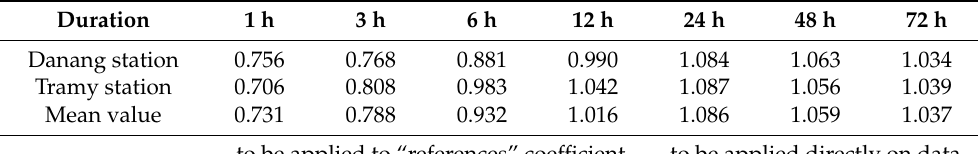
Table 2. Correlation coefficient between daily and hourly maximum precipitation